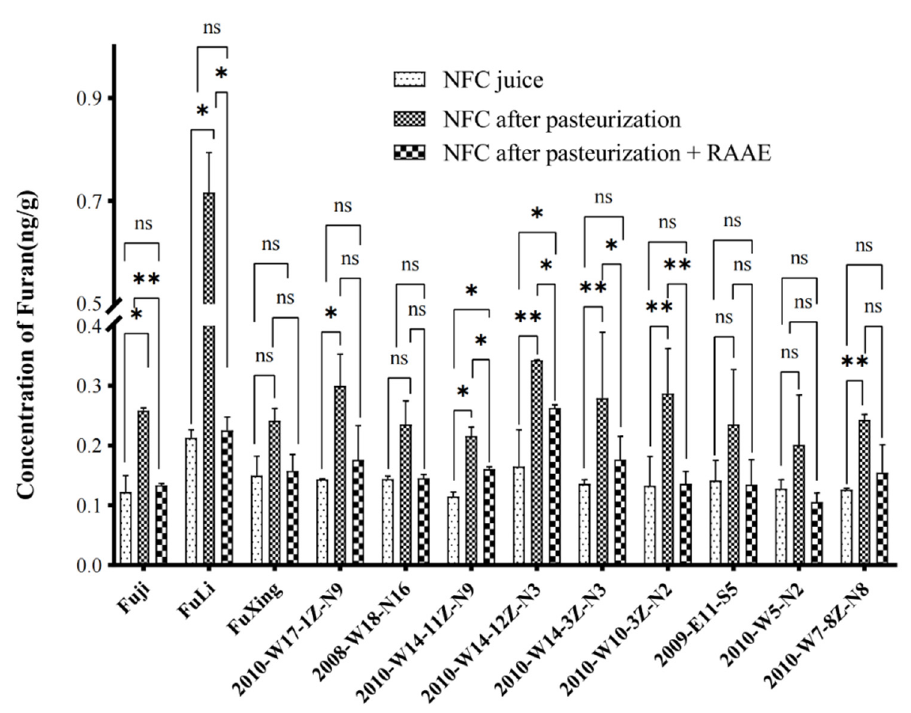
Figure 7. The furan content of NFC apple juice after pasteurization and the reducing effect of RAAE on furan afterward. * means p < 0.05, ** means p < 0.01, and ns means no significant difference.